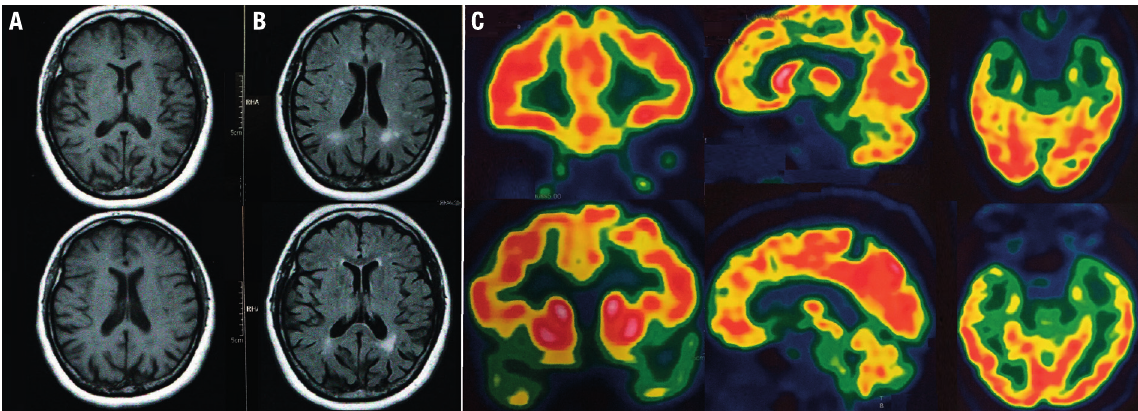
Figure 1. A. Magnetic resonance imaging (MRI) of brain showing moderate parietal atrophy and no focal frontotemporal atrophy. B. Moderate white matter disease on brain MRI. C. Positron emission tomography with fluorodeoxyglucose (PET-FDG) showing marked hypometabolism in temporal poles and anterior cingulate; there is mild hypometabolism in the orbitofrontal cortex, medial temporal regions (including hippocampus) and temporo-parietal cortex. No hypometabolism is evident in the precuneus and posterior